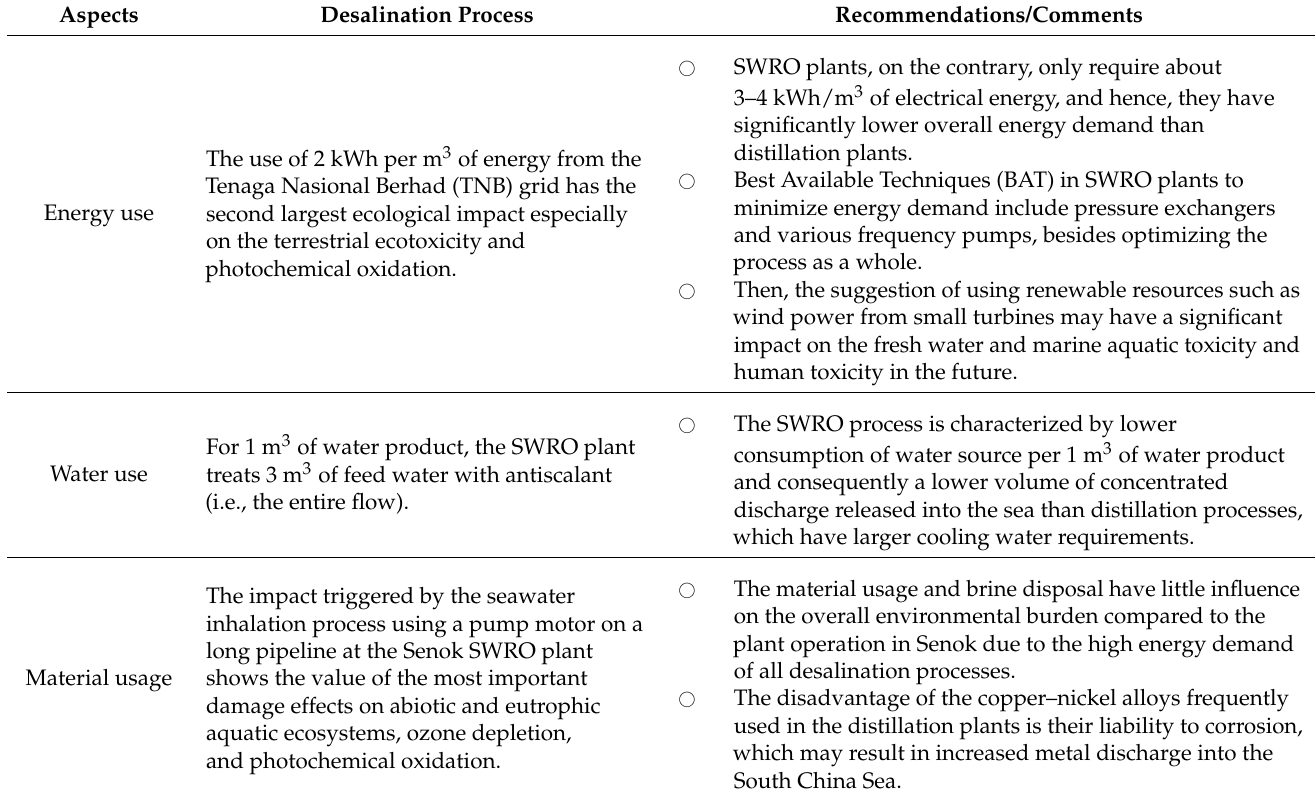
Figure 4. Impact assessment results for the operational phase. Table 3. The alternative options for the mitigation aspects of the SWRO system.